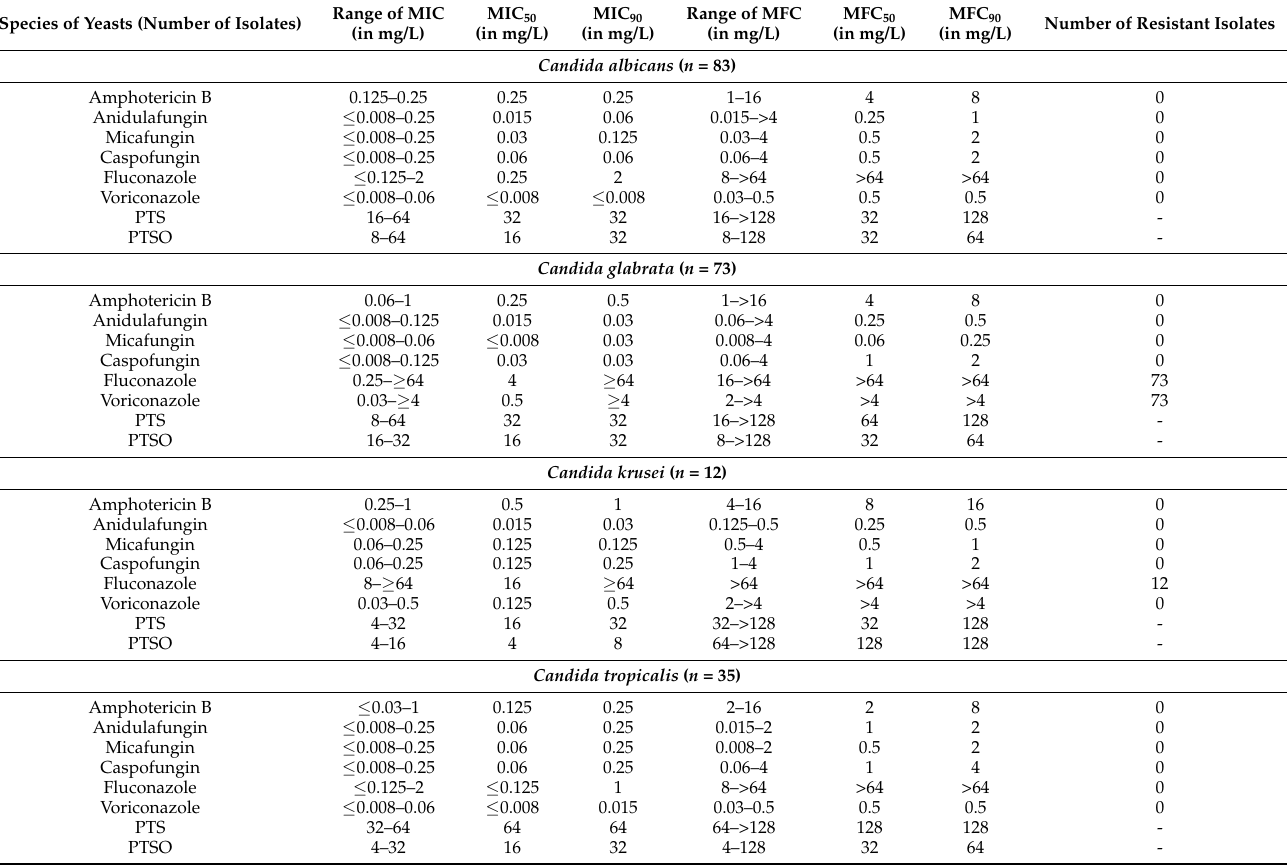
Table 1. In vitro activity of different antifungal drugs, PTS, and PTSO against Candida spp. Species of Yeasts (Number of Isolates) Range of MIC (in mg/L) MIC 50 (in mg/L) MIC 90 (in mg/L) Range of MFC (in mg/L)